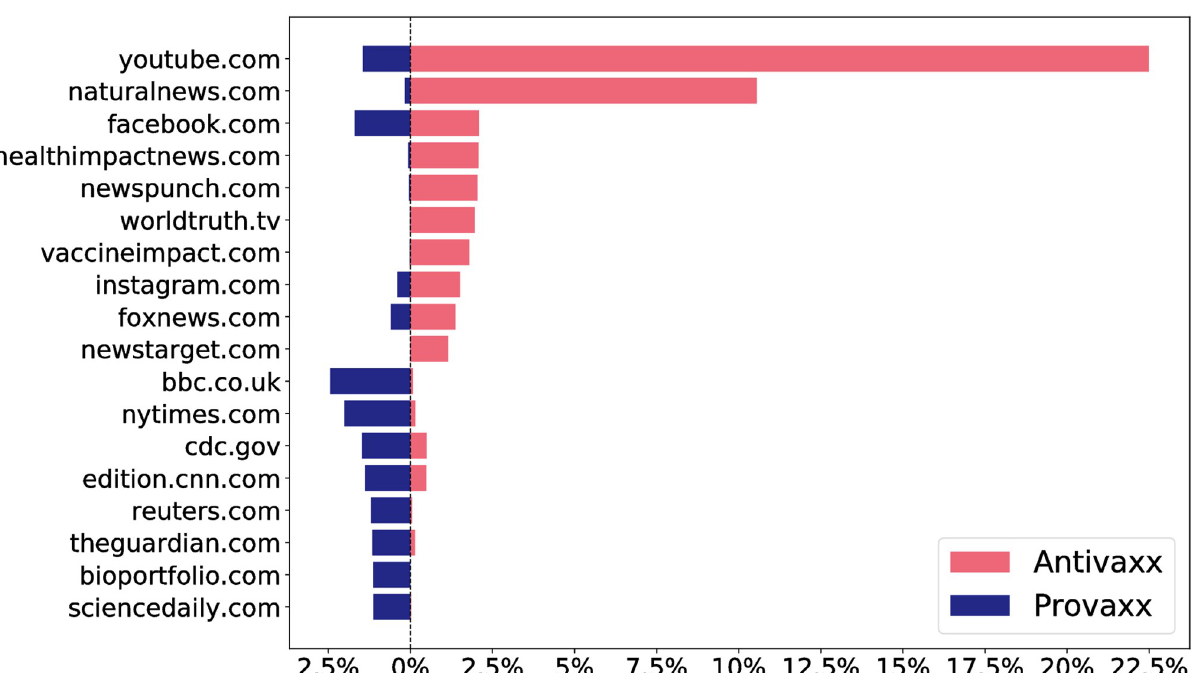
Fig 2. The top 10 most linked to domains by strongly antivaxx and provaxx profiles. Bar length shows percentage of the total number of links shared by profiles in the given category and hence do not sum to 100. For each domain, the red bars going right represent antivaxxers and blue bars going left provaxxers. Antivaxxers rely heavily on links to YouTube, and the page ‘natural news’, which promulgates pseudoscience and sells products related to health and nutrition. Provaxxers link to a wide array of news and science sites, which is why a lower overall percentage of their links are contained in the top 10. Error bars are too small to depict visually, see S1 Appendix for uncertainty